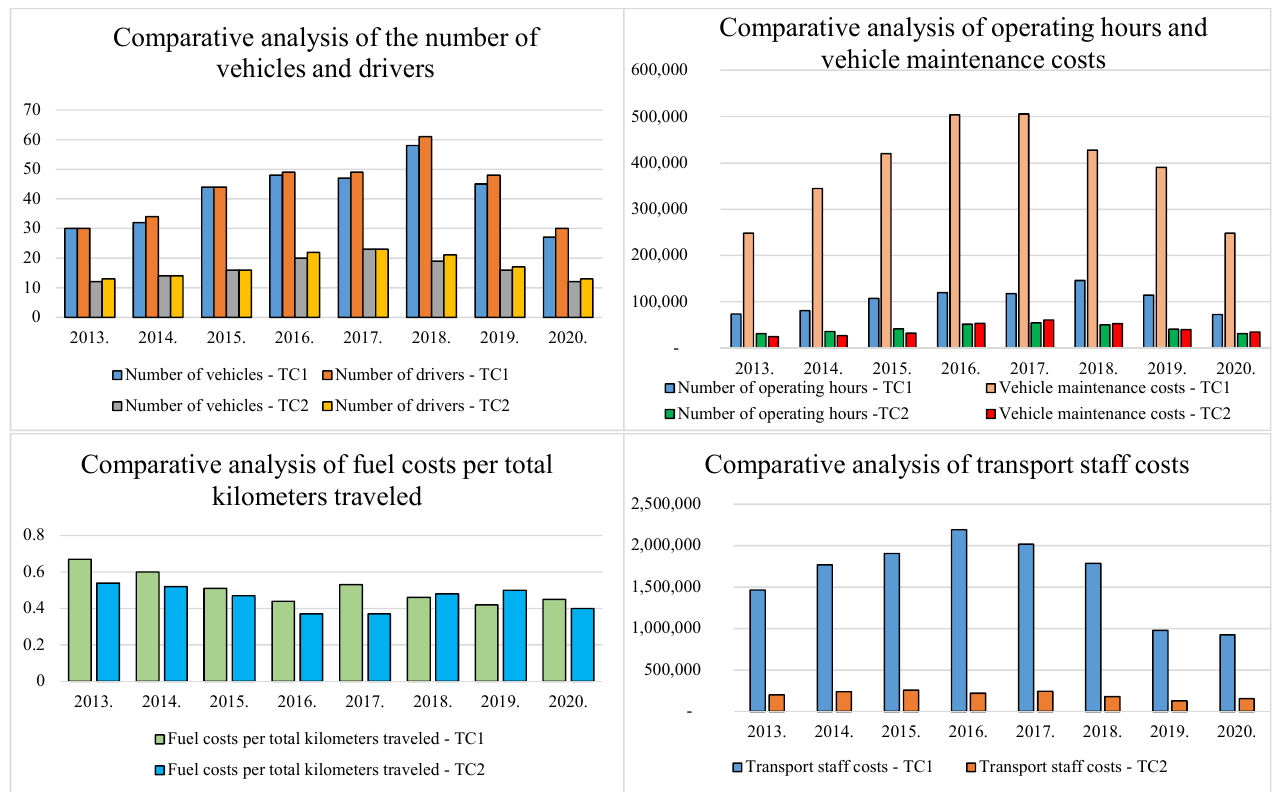
Figure 6. Graphical representation of a comparative analysis of the number of vehicles, drivers, operating hours, vehicle maintenance costs, fuel costs, and transport staff